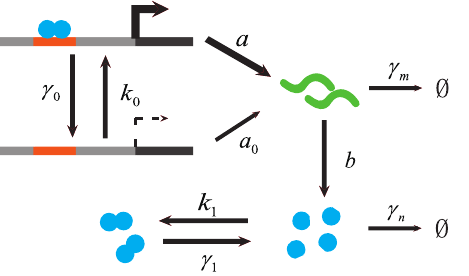
Figure 1. The autoregulatory dimer model with positive feedback. Promoter transitions are regulated by the dimerized transcription factor with rate k 0 and r 0 . a is the transcription rate of active promotor, with a very small transcription rate of inactive promotor a 0 . b is kinetic rate of translation, c m and c n are degradation rates of mRNA and protein, k 1 and c 1 are the rates of dimerization and de-dimerization. All the processes are modeled as elementary reactions and all reaction rates are rescaled by the protein decay rate (i.e. c n ~ 1 unless stated otherwise).